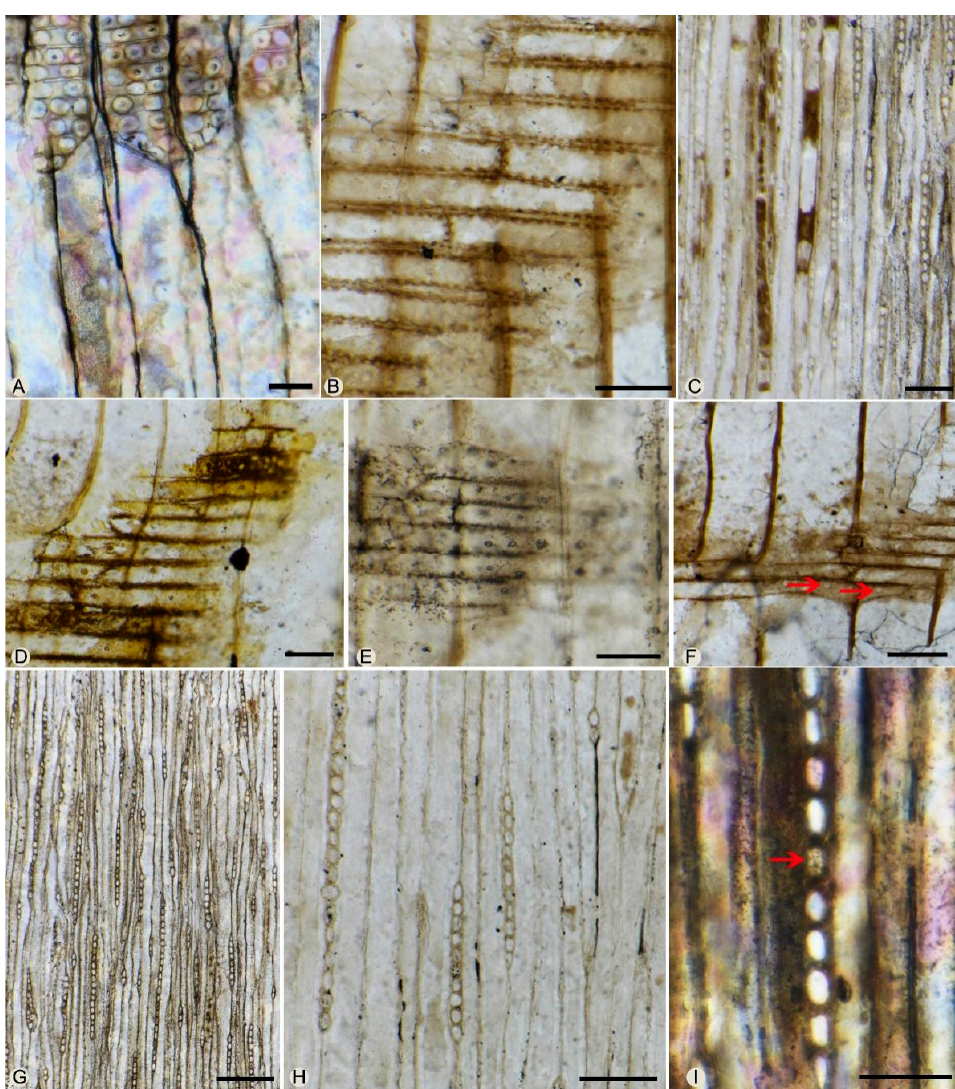
Figure 4. Keteleerioxylon changchunense Shi, Sun, Meng et Yu sp. nov. ( A ). Radial section showing the opposite and alternate biseriate pits and triseriate pits and the crasulae on the radial walls of tracheids. ( B ). Radial section showing pitted horizonal and end walls of the ray parenchyma cells. ( C ). Tangential section showing the axial parenchyma cell. ( D , E ). Radial section showing taxodioid-cupressoid type cross-field pits. ( F ). Radial section showing the marginal ray cells resembling ray tracheids with scattered uniseriate pits (red arrows). ( G ). Tangential section showing uniseriate, partly biseriate rays. ( H ). Close-up of the rays showing uniseriate rays. ( I ). Tangential section showing the pitted end wall of ray parenchyma cell (red arrow). Scale bar: A, B, D, E, F, I = 50 μ m; C, H = 100 μ m; G = 200 μ m.